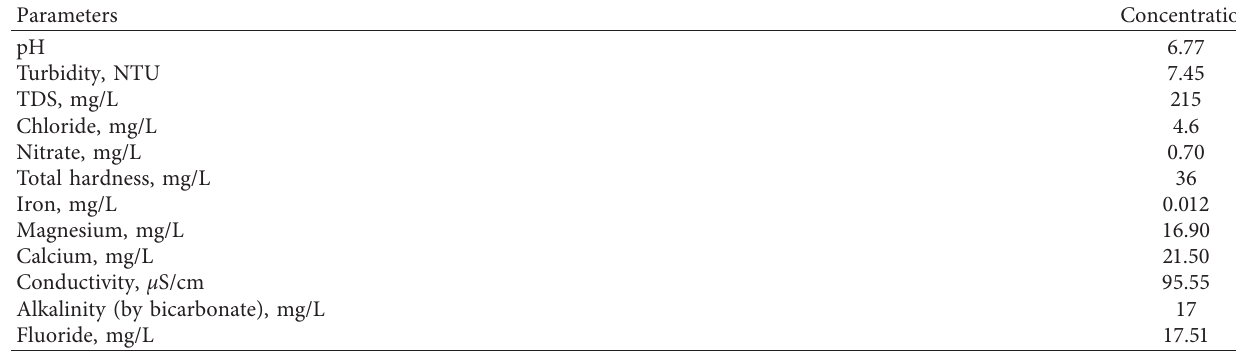
Table 3: Physicochemical parameters of the well water ≠ 1 used in the experiment.